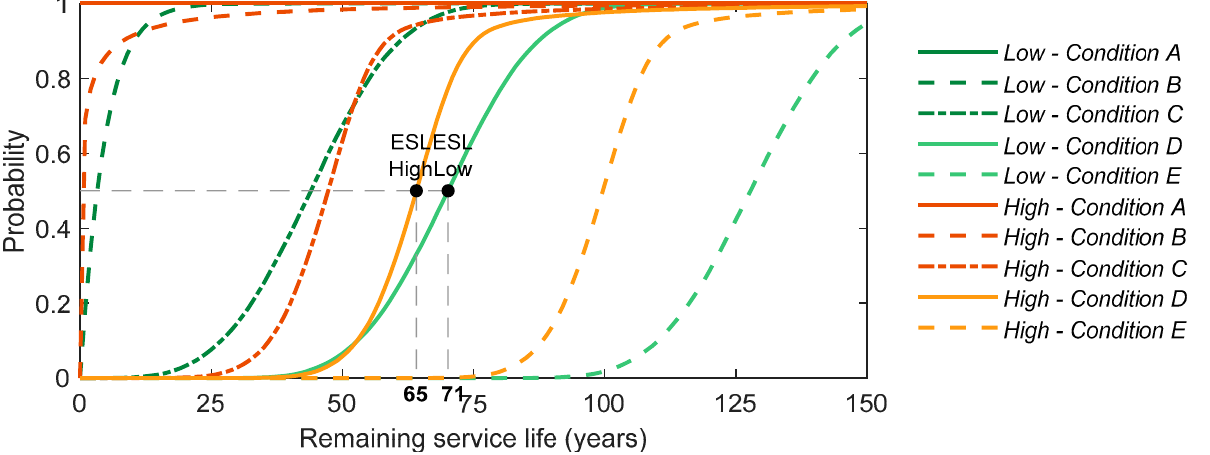
Figure 10. Cumulative distribution functions of the five degradation conditions over time horizon for both heights.